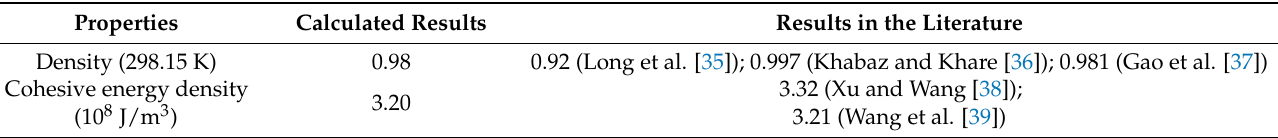
Figure 5. Densities of three types of asphalt models. Table 2. Calculated results of virgin asphalt in MD simulations.